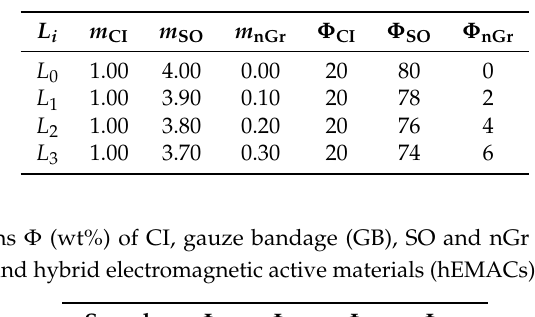
Table 1. The mass m (g) and mass fractions Φ (wt%) of CI, silicone oil (SO) and graphene nanoplatelets (nGr) inside the polyphasic liquids L i , i = 0,1,2,3.